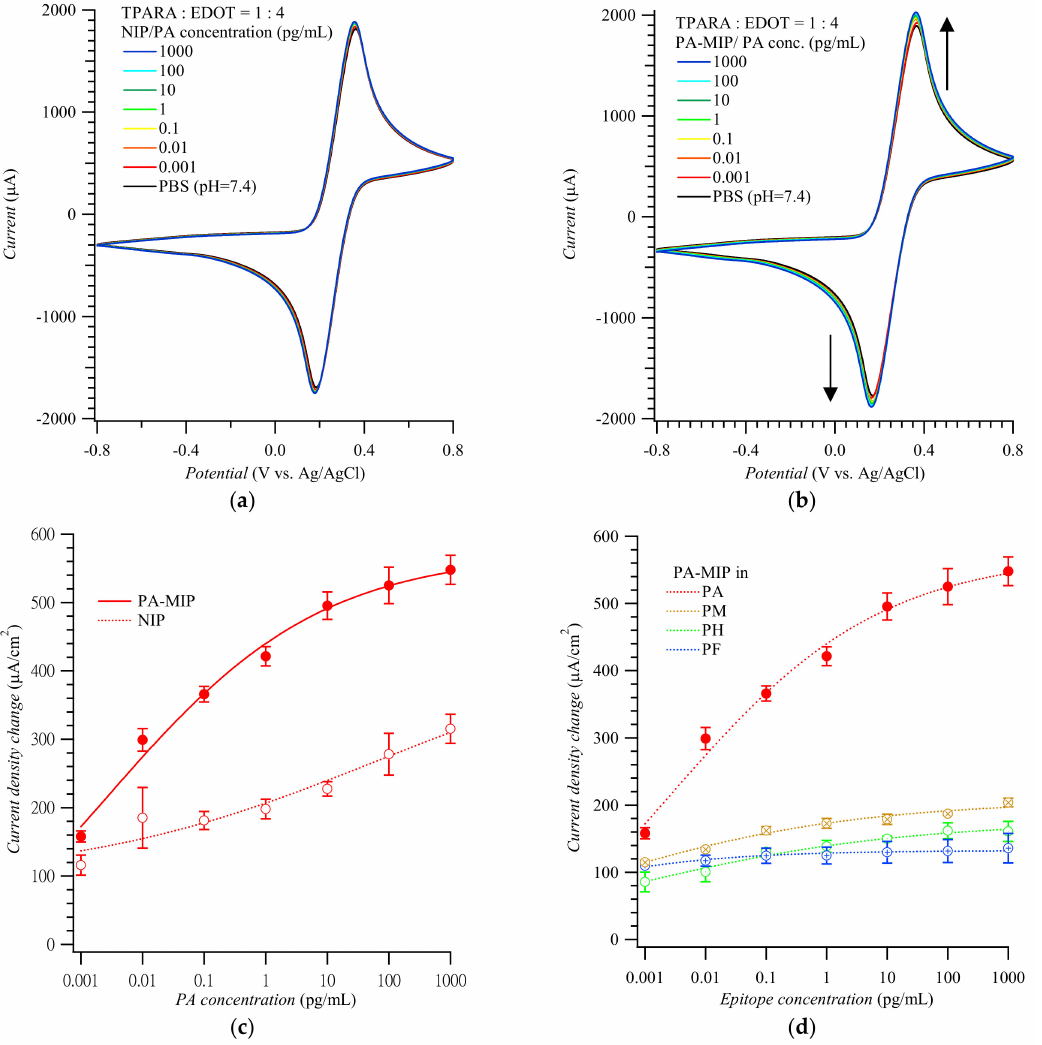
Figure 2. Cyclic voltammograms for target epitopes at different concentrations using ( a ) the NIP- and ( b ) PA-templated poly(TPARA- co -EDOT) film-coated electrodes; vertical arrows indicate current changes in consecutive cycles. ( c ) Calibration plots for the PA analyte epitope from ( a , b ). ( d ) In- terfering effect of other epitopes from MMP-1 at various concentrations. Peak current changes were measured at anodic peak potentials of 0.24 to 0.29 V vs. Ag/AgCl in 125 mM KCl, 5 mM K 4 Fe(CN) 6 , and 5 mM K 3 Fe(CN) 6 . Peptides PA, PH, PM, and PF are AQDDIDGIQAI,